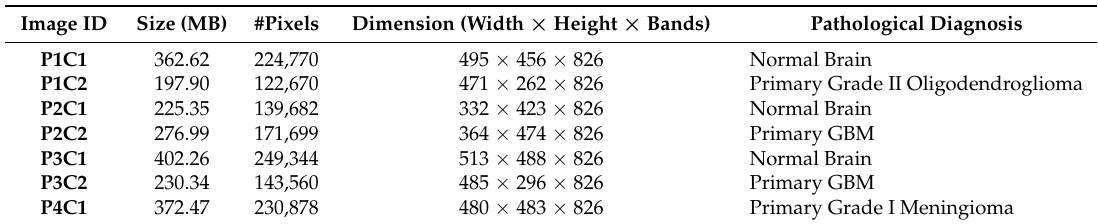
Table 2. Validation HS image dataset